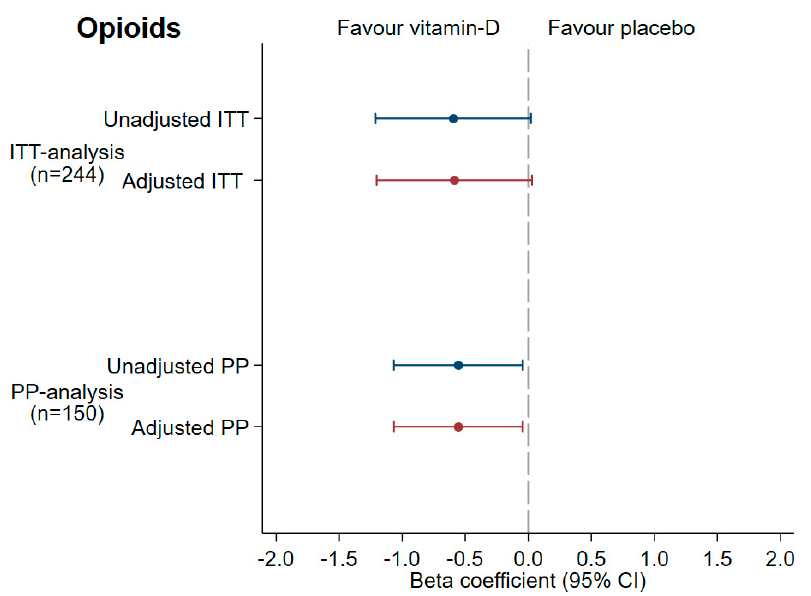
Figure 2. Main analysis: forest plots with beta coefficient and 95% CI over the opioid use in the ‘Palliative-D’ study. The intention-to-treat (ITT) analyses include all 244 randomized patients, and the Per Protocol (PP) analysis is based on the 150 patients that completed the 12-week study period (vitamin D 4000 IE/day n = 67 and placebo n = 83). Adjustments were made for the baseline in all analyses and for age, sex, oncological treatment, baseline 25-hydroxyvtaim D and colectomy in the “adjusted model.”